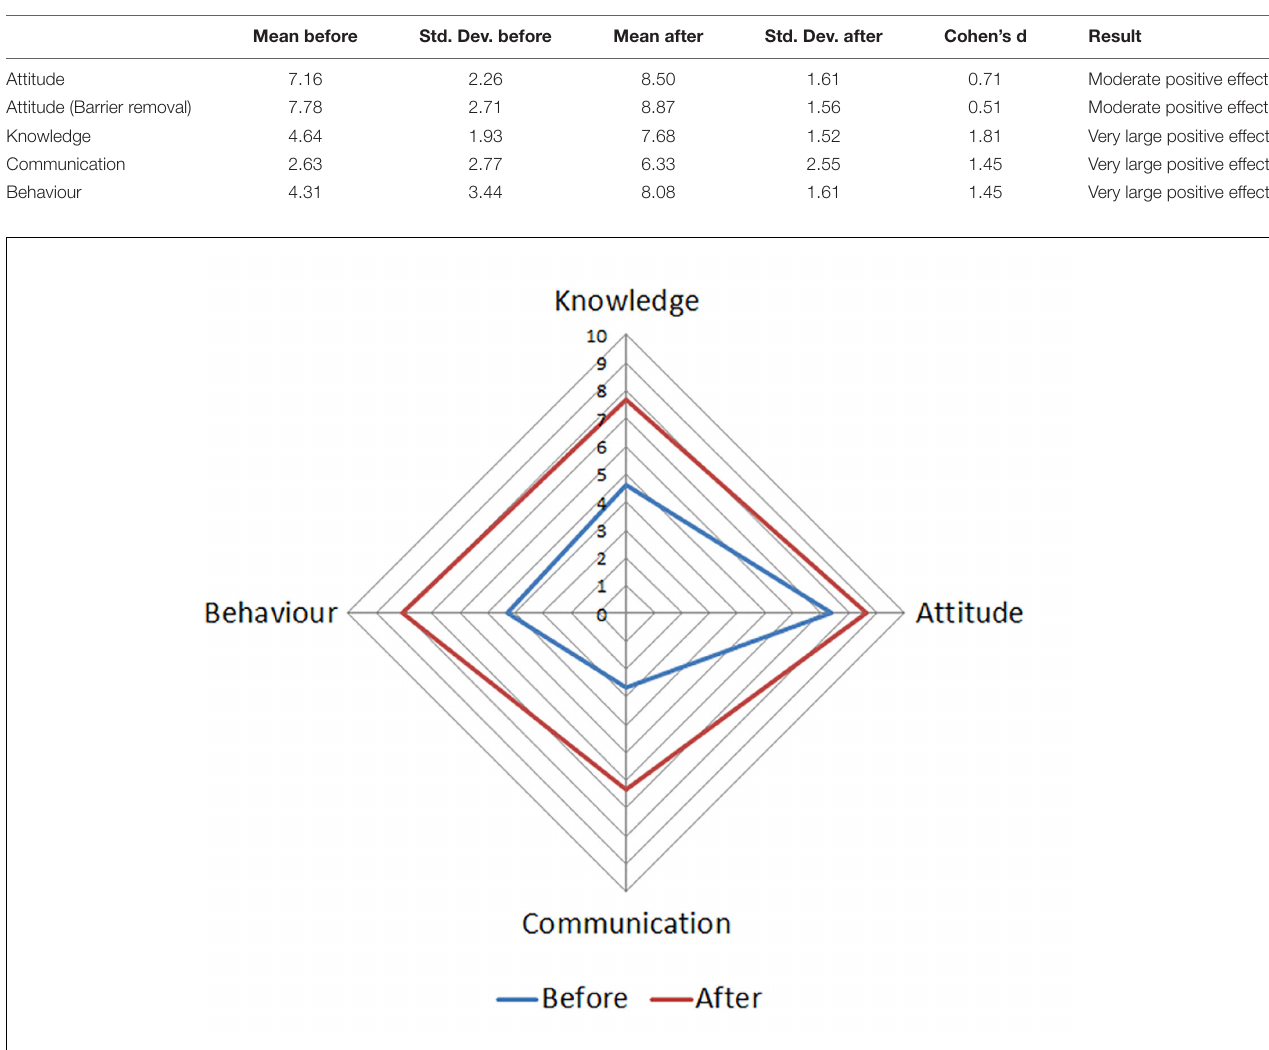
FIGURE 6 | Radar chart showing changes in four of the dimensions of Ocean Literacy before and after use of the